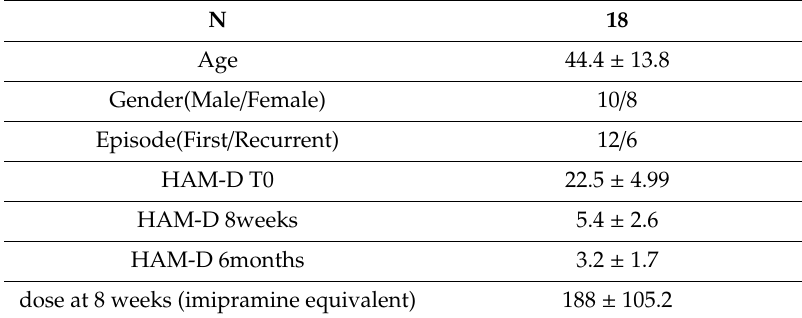
Table 2. The characteristics of patients, the HAMD score, and dose of